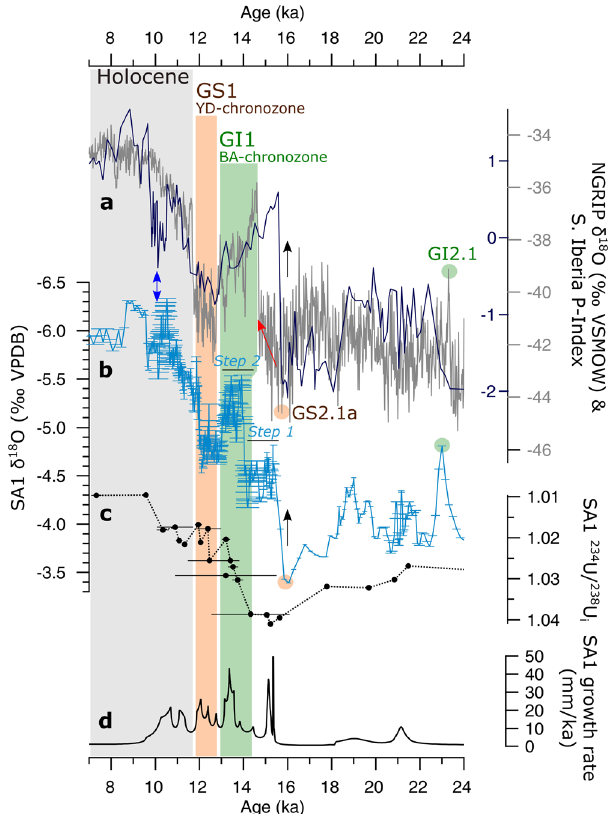
Fig. 3 SA1 δ 18 O time series compared to circum-Mediterranean records. a Ice rafted debris (IRD) from the Gulf of Biscay related to the HS1 event (black fi ll 47 ), Portugal Margin SST (red line 50 ) and Greenland ice-core δ 18 O (grey line 10 ). b Ostolo Cave stalagmite δ 18 O, a proxy for northern Iberian temperature (yellow line 44 ). c SA1 δ 18 O (light blue line, this study) taken as palaeo-rainfall proxy and Adriatic SST (red line 51 ). d Planktonic foraminifera from the Aegean Sea (brown line 49 ), the Tyrrhenian Sea (purple line 48 ) and the Iberian Margin (dotted orange line 46 ), proxies for Mediterranean planktonic-derived temperatures. e Pollen from Monticchio (green and brown fi ll 26 ) and Tenaghi Philippon lakes (yellow dotted line 27 ), representing vegetation changes. For locations see Fig.